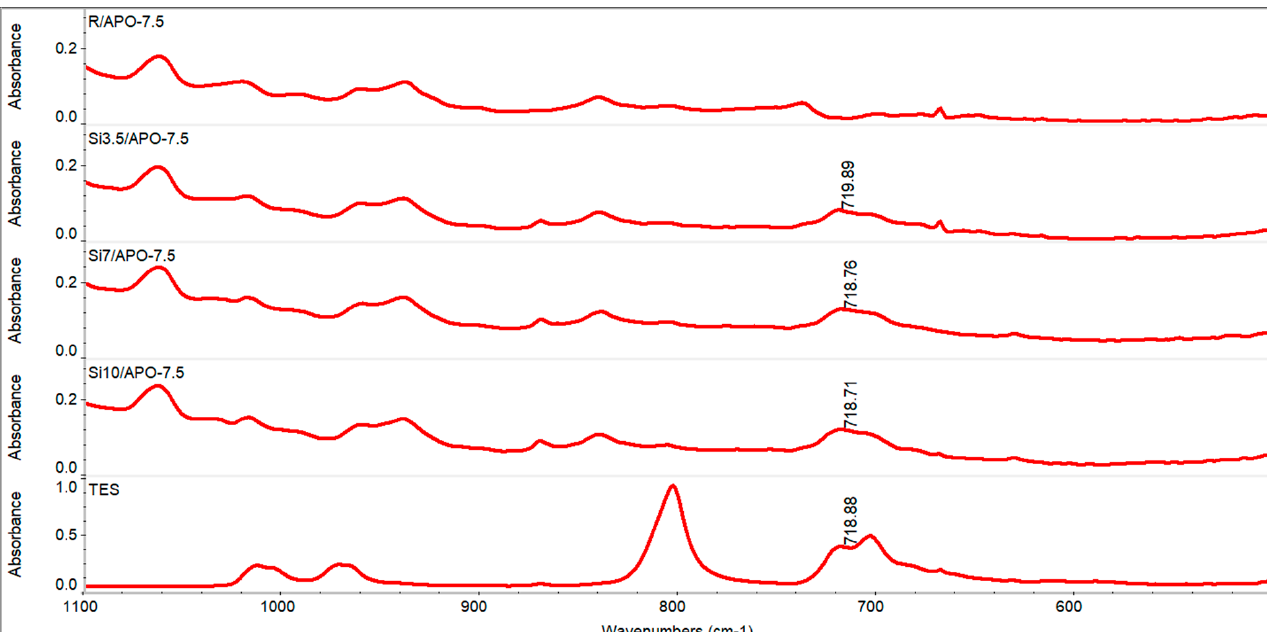
Figure 6. FT-IR spectra of TES, dry systems consisting of Si telomers (with the same content of 0.075 wt. parts APO), and dry reference with the same APO concentration.